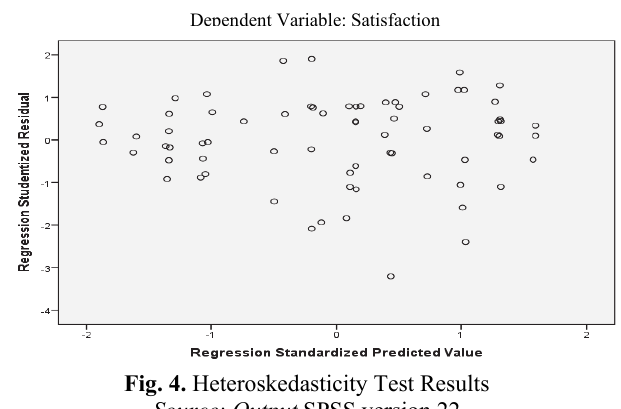
Fig. 4. Heteroskedasticity Test Results Source: Output SPSS version 22